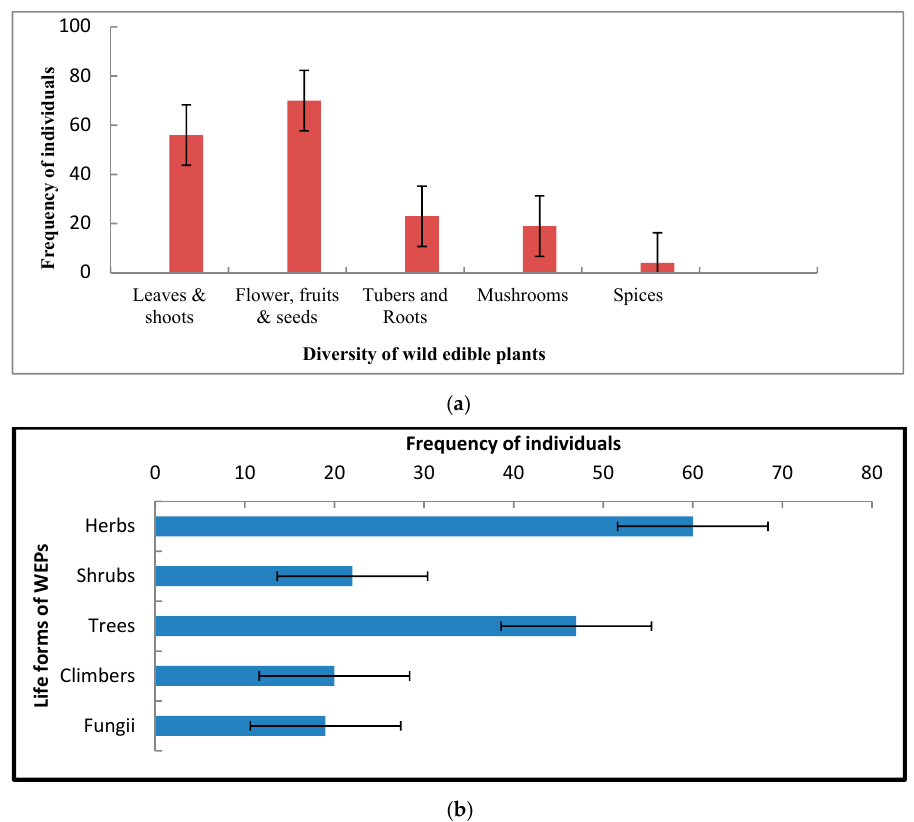
Figure 2. ( a ): Diversity of wild edible plants (WEPs) utilized by indigenous communities of AABR, Central India (N = 332; ±SEm of frequencies); ( b ): Frequency of life forms of WEPs utilized by indigenous communities of AABR, Central India (N = 332; ±SEm of frequencies).